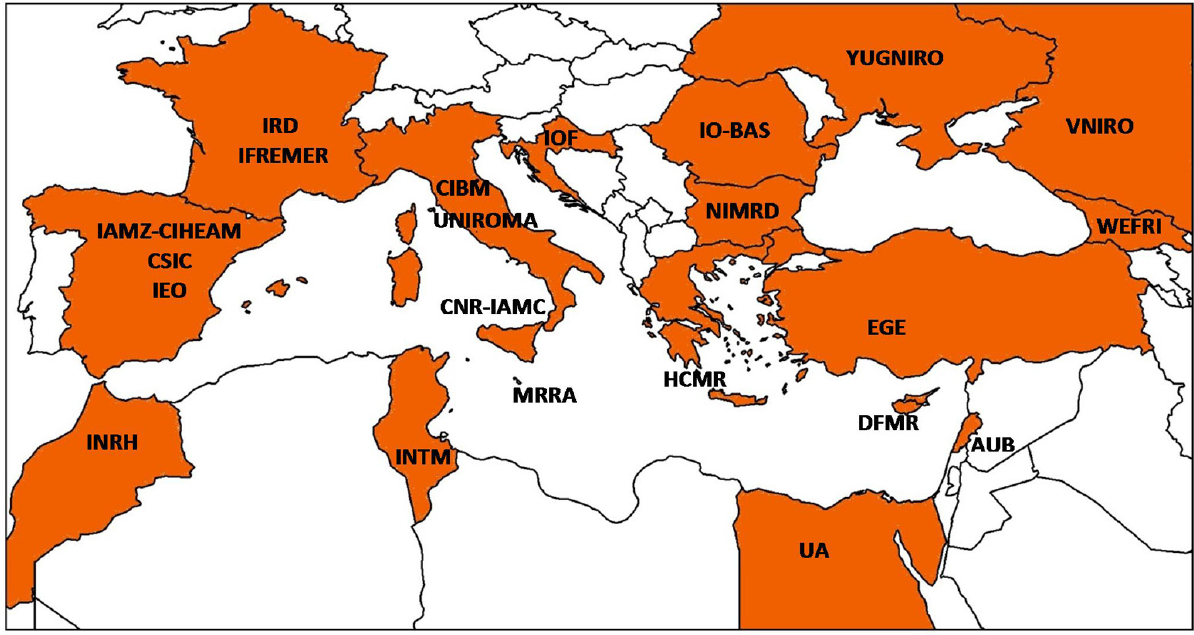
Fig. 1. – Mediterranean and Black Sea countries (coloured areas) and institutions of origin of the experts participating in the present work. IAMZ-CIHEAM, Mediterranean Agronomic Institute of Zaragoza. International Centre for Advanced Mediterranean Agronomic Studies. Zaragoza, Spain; CISC, Agencia Estatal Consejo Superior de Investigaciones Cientificas, Madrid, Spain; HCMR, Hellenic Centre For Marine Research. Athens, Greece; CIBM, Consorzio per il Centro Interuniversitario di Biologia Marina ed Ecologia Applicata “G. Bacci”.